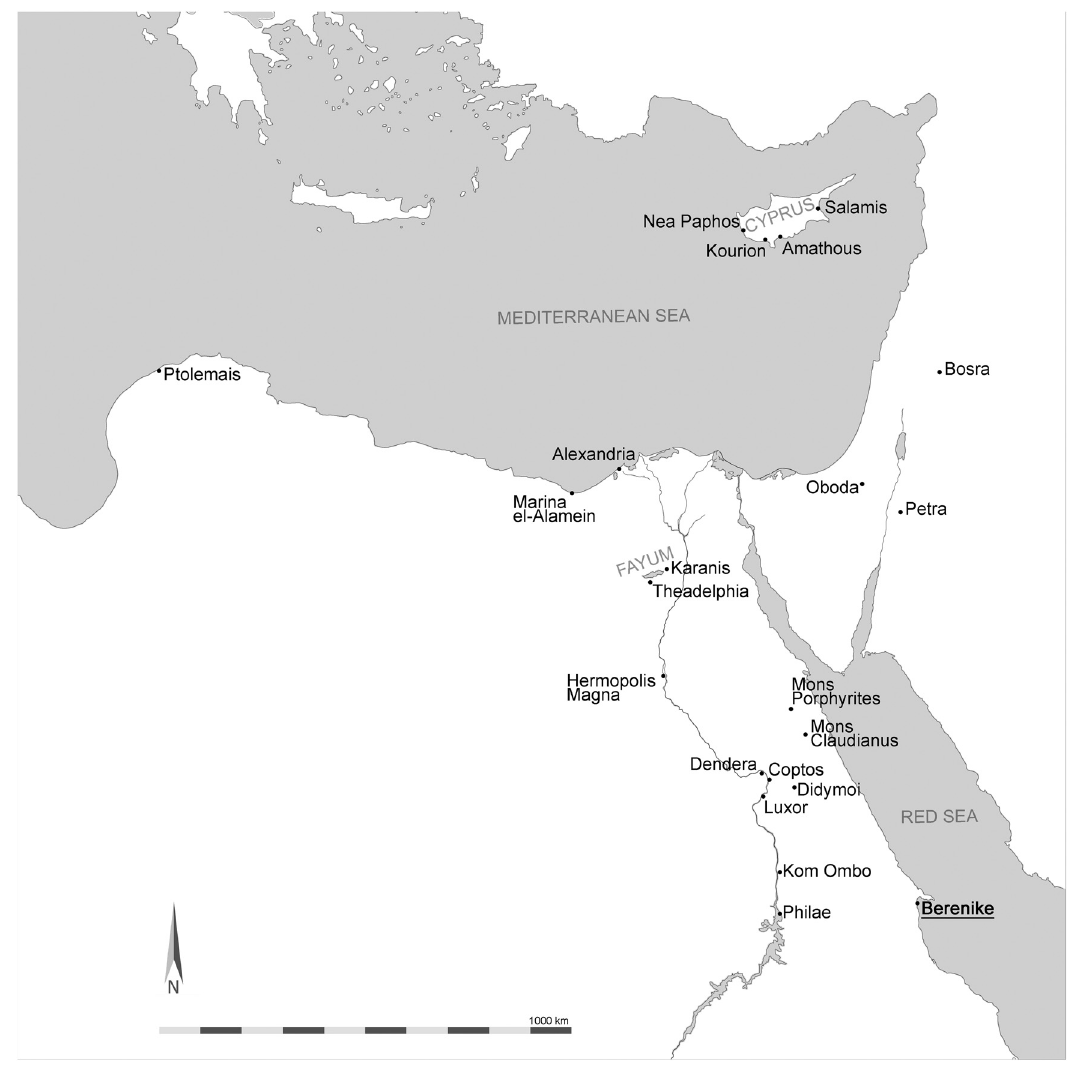
Figure 1: Map of Egypt and vicinity with locations of cities mentioned in the text ( drawing: S. Pop ł awski )